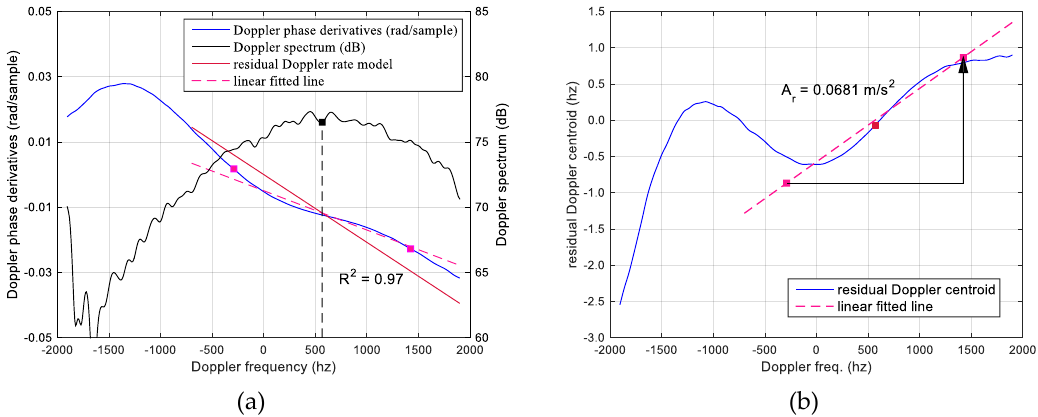
Figure 3. Application results from speed-controlled vehicle 1 in Figure 2. ( a ) Doppler spectrum (black solid line), Doppler phase derivatives (blue solid line), and residual Doppler rate model (red solid line) in the Doppler frequency domain. The residual Doppler centre frequency is represented by a black dashed line and a black square. ( b ) The across-track acceleration estimated through the least-squares regression applied to the residuals. A bandwidth of 1717 Hz or 0.316 s around the Doppler centroid is used for acceleration estimation, as seen in ( b ). Note that the correlation is 0.97 between the Doppler phase derivatives and the model from the residual Doppler rate.